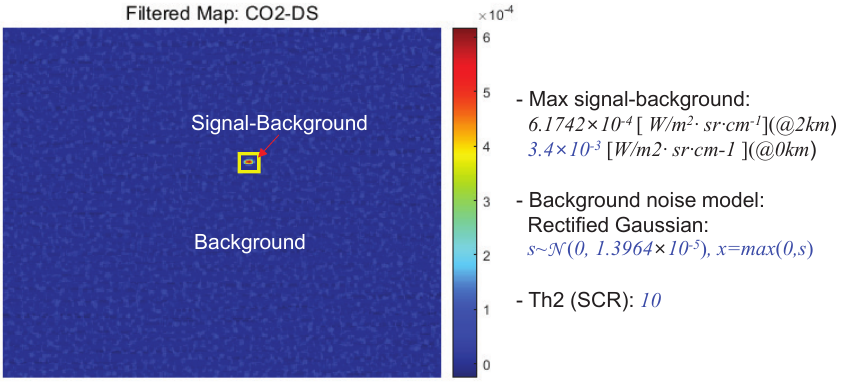
Figure 19. MODTRAN environment for atmospheric transmittance calculation.